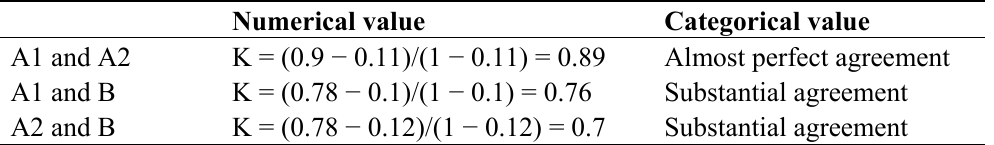
Table 3. Kappa values for the distribution pattern of the observer’s observations concerning isoenhancement and hypoenhancement.